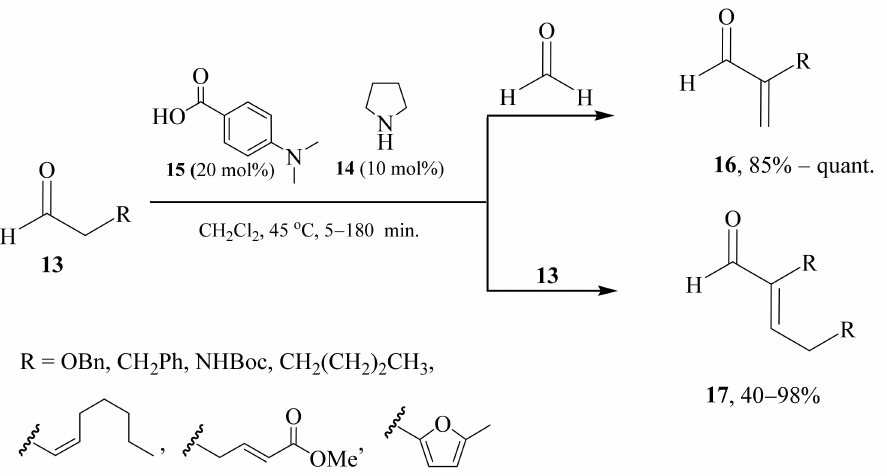
Scheme 4. Synthesis of α -substituted α , β -unsaturated aldehydes by organocatalytic Mannich con- densation of aldehydes 13 .